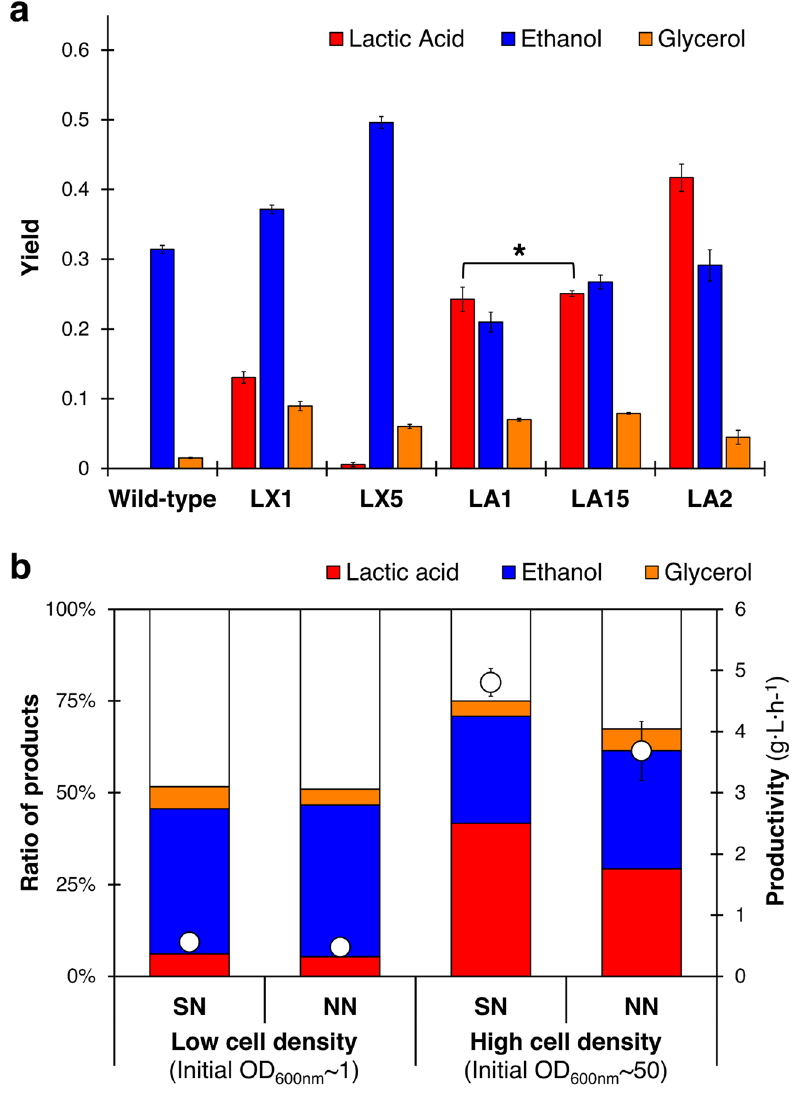
Figure 4. The effect of pathway engineering on the fermentation products of Saccharomyces cerevisiae BTCC3 ( a ) and cell density on ratio of products and lactic acid productivity in Saccharomyces cerevisiae BTCC3LA2 under semi-neutralized (SN) and non-neutralized (NN) cultivations ( b ). Values represent the average measurement of four biological replicates. Error bars represent the standard deviation of measurements. Bars indicated by an asterisk represent a statistically insignificant correlation (Student’s t-test, P ≤